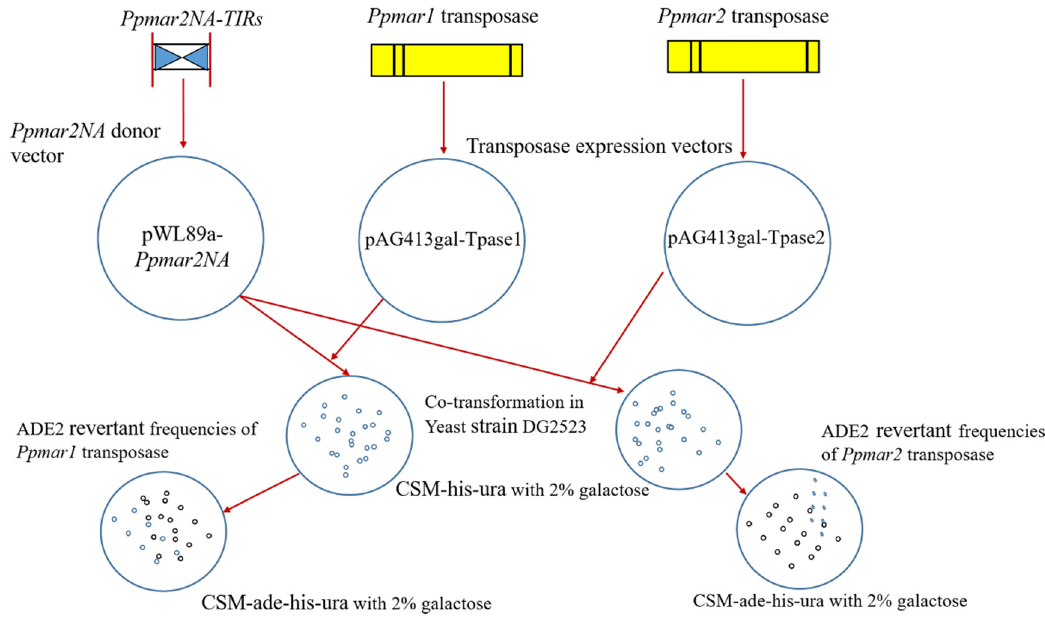
Figure 7. The vector constructs and workflow of Ppmar2NA -TIRs transposition assay in yeast cells